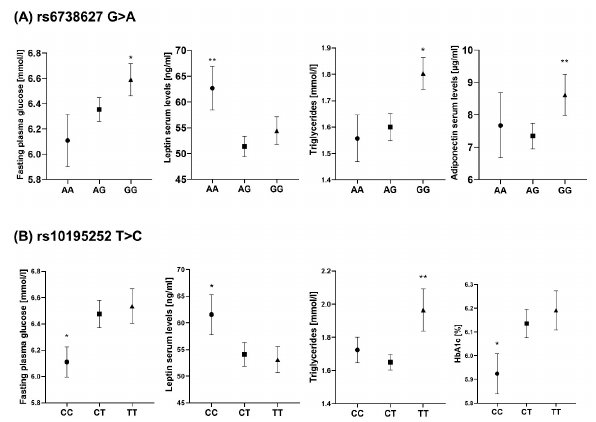
Figure 5. Association analyses of rs6738627 and rs10195252 with metabolic traits. ( A ) Association analyses of rs6738627 with FPG, leptin, TG, and adiponectin. ( B ) Association analyses of rs10195252 with FPG, leptin, TG, and HbA1c. * p < 0.05; ** p < 0.01; p adjusted for sex, age, and BMI. 2.4. Genotype-Specific mRNA Expression at Loci Associated with WHR and Body Fat The eQTL (expression Quantitative Trait Loci) data can implicate regional transcripts